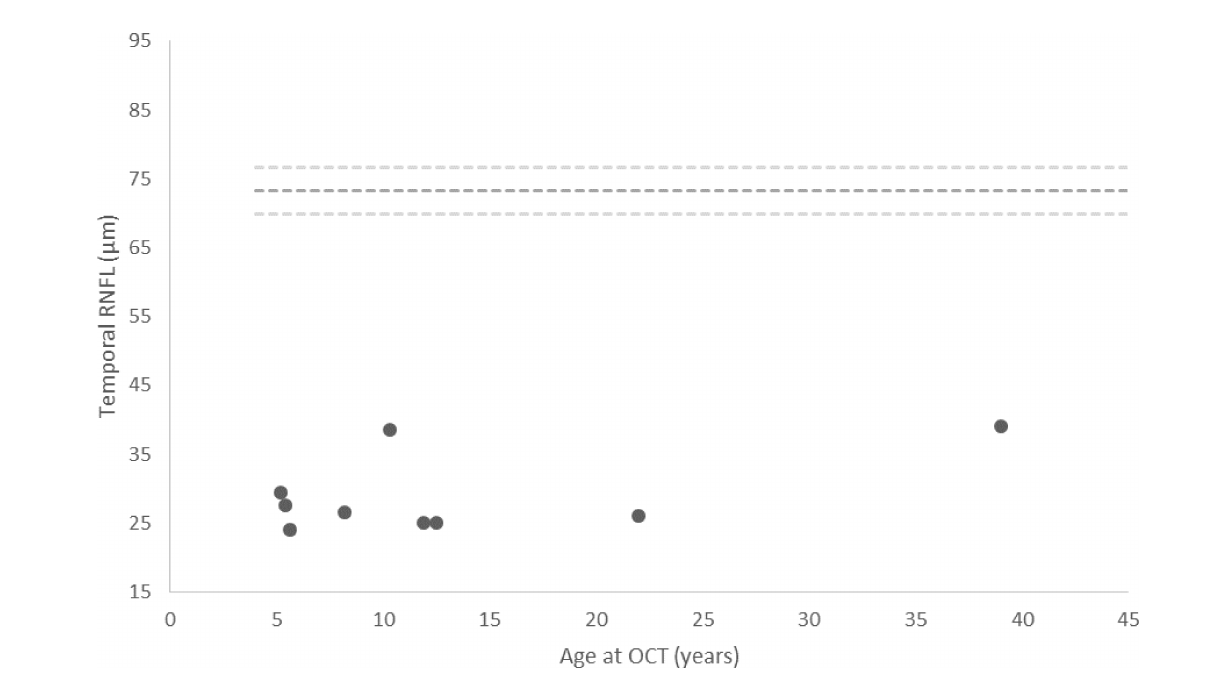
FIGURE 1 | Temporal RNFL thickness measured at initial OCT in patients with Triple A syndrome. Each value is the mean between two eyes. The dashed lines represent the mean ± 2SD of the reference range (20). Of note, the outliers that display a temporal RNFL of nearly 40 µm are the mother and daughter pair.